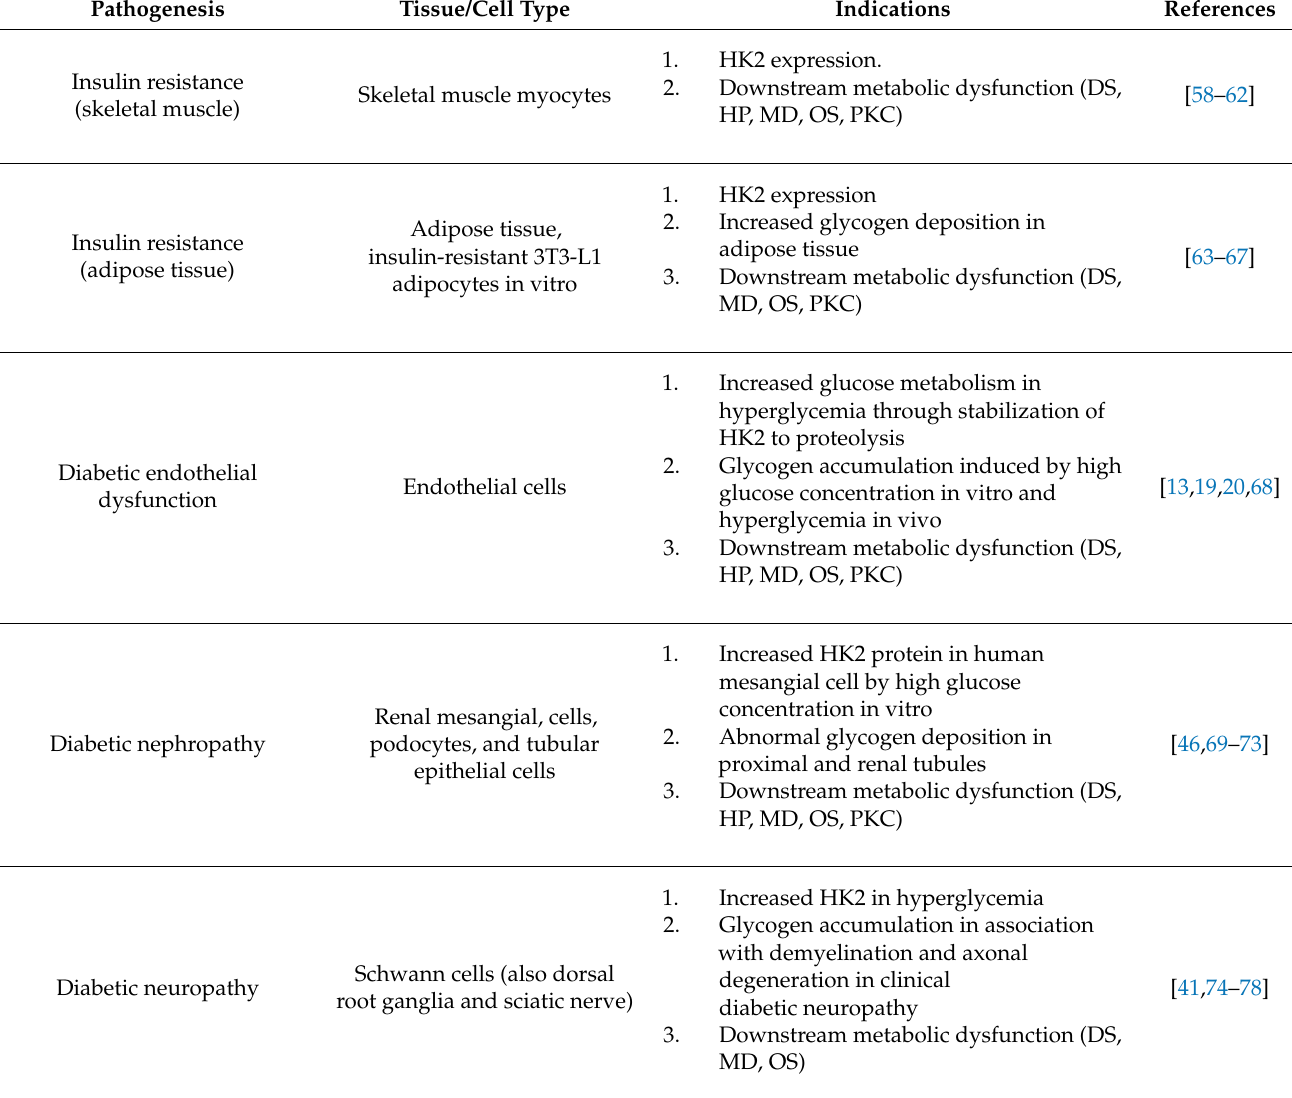
Table 1. Evidence for hexokinase-driven glycolytic overload and unscheduled glycolysis in insulin resistance, vascular complications of diabetes, and diabetic